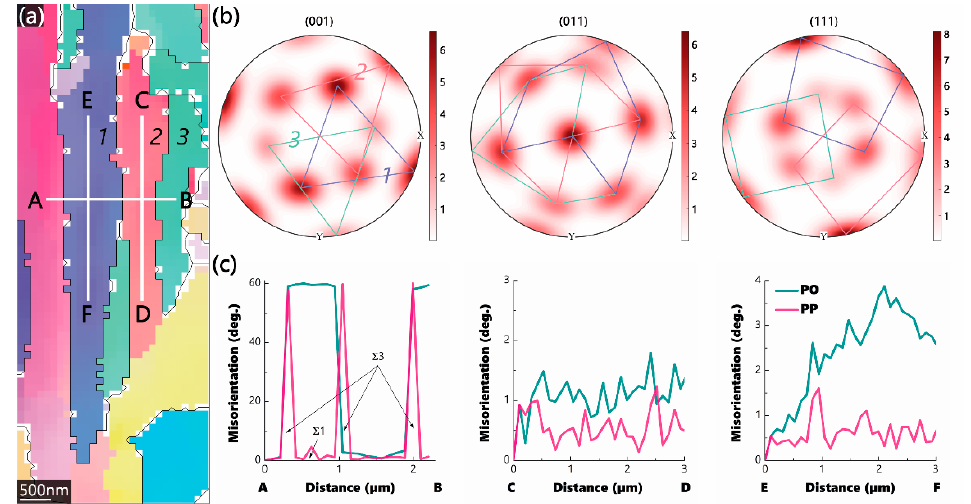
Figure 5. Origin of the 6-fold symmetry. ( a ) Inverse pole figure (IPF) coloring of lath-shaped microstructure in 42CrMo4 steel austempered below M S . The pixel (step) size of the EBSD scanning is <100 nm; ( b ) pole figures of an orientation distribution function (ODF) of the scanned area in ( a ) to represent the symmetry about the (001), (011), and (111) poles. The point orientations from the individual blocks in ( a ) are connected with solid lines in the identical color blocks; ( c ) fluctuations of misorientations along the straight lines A–B, C–D, and E–F drawn in ( a ). PO: point-to-origin misorientation; PP: point-to-point misorientation.